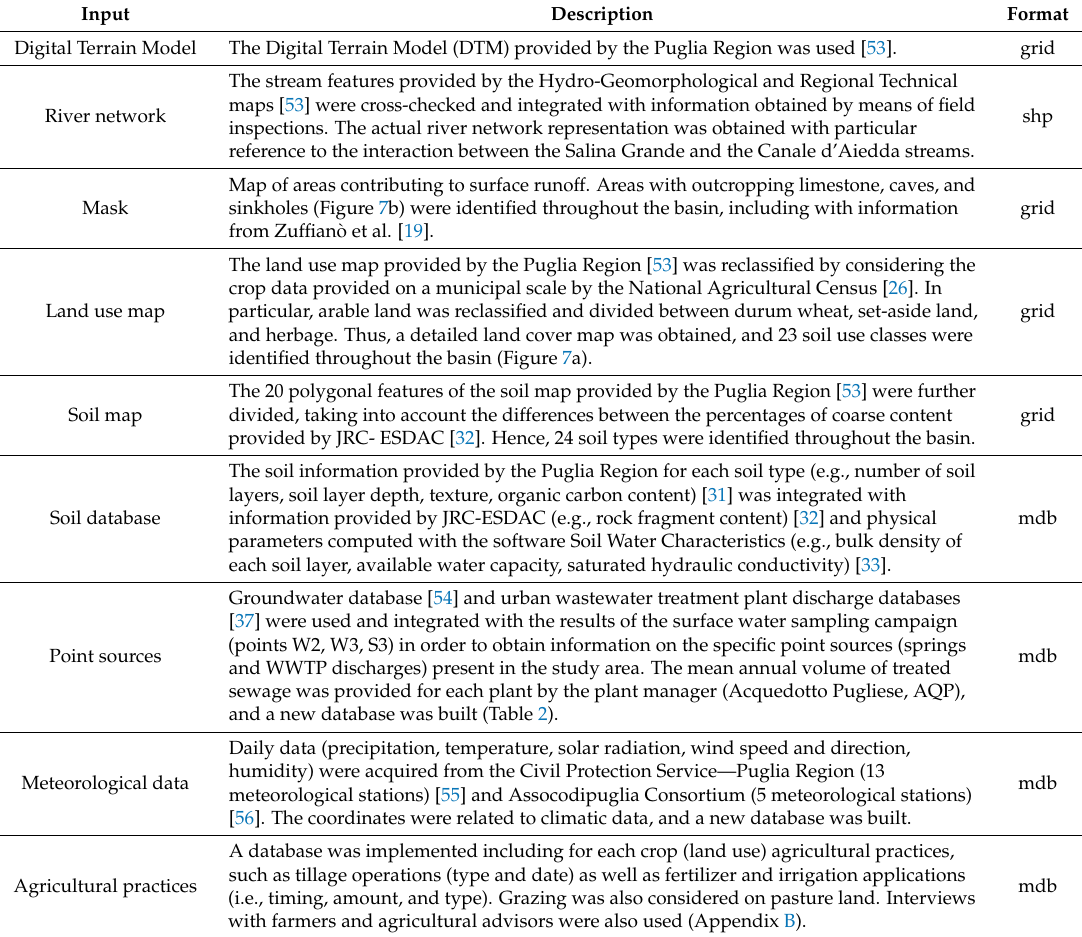
Table 1. Data included in the geodatabase. Researchers may obtain access to the geodatabase via the corresponding